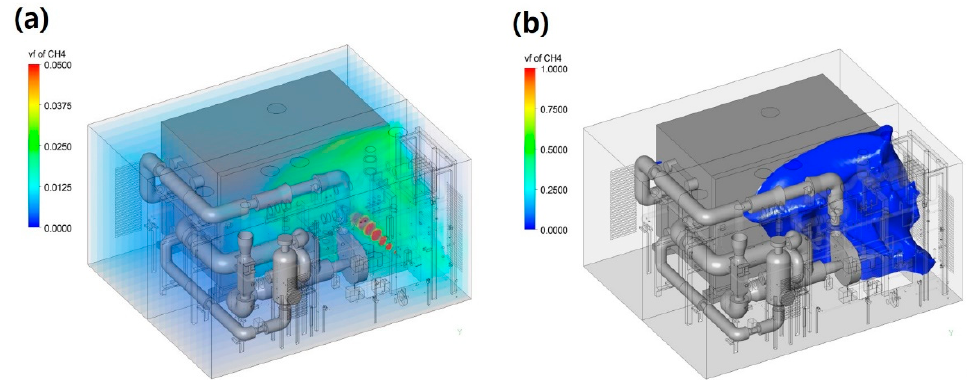
Figure 5. ( a ) Volume fraction distribution and ( b ) 2% iso-surface of leaked methane inside the MCFC stack package.